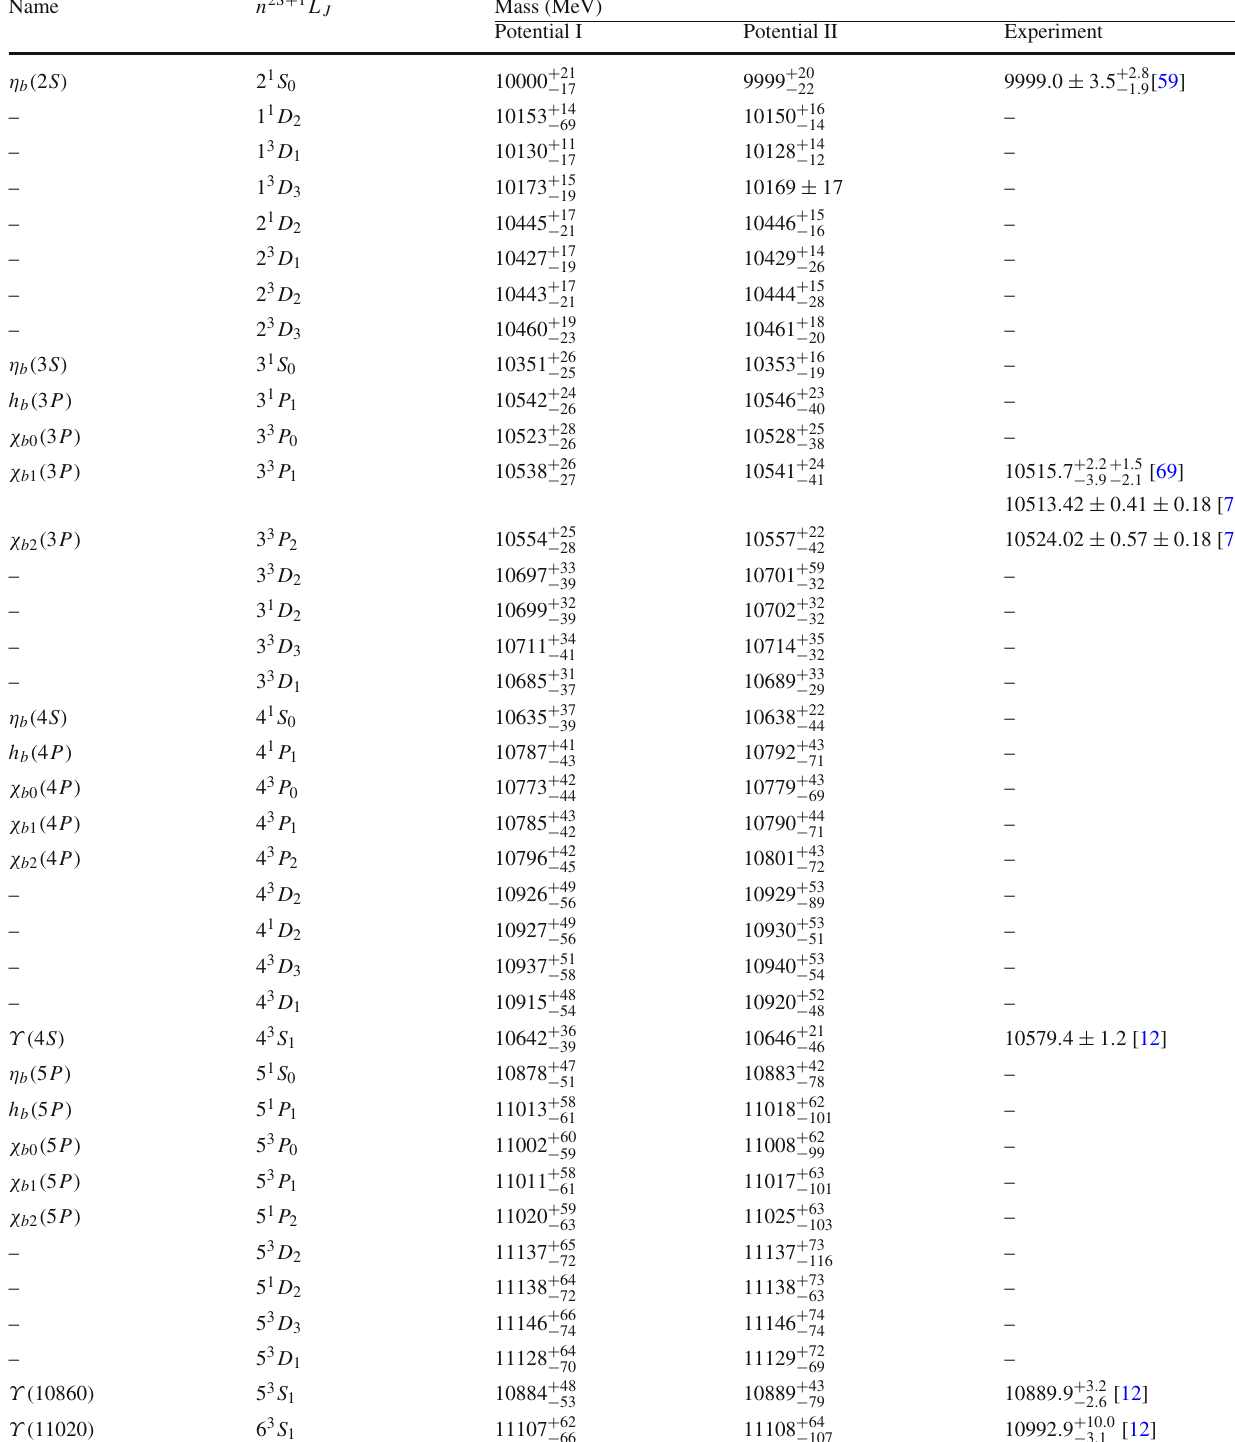
Table 5 Predicted bottomonia for potentials I and II compared to the existing experimental masses with their corresponding uncertainties. Notation as in Table